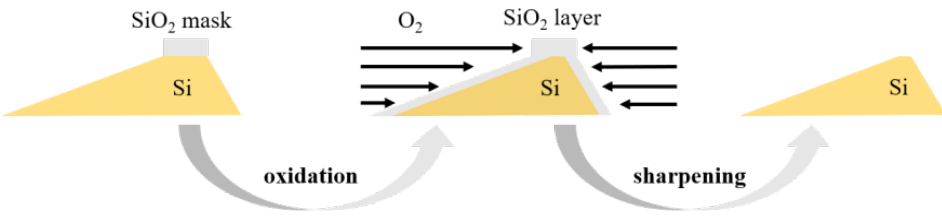
Figure 10. Schematic diagram of oxidation sharpening process.